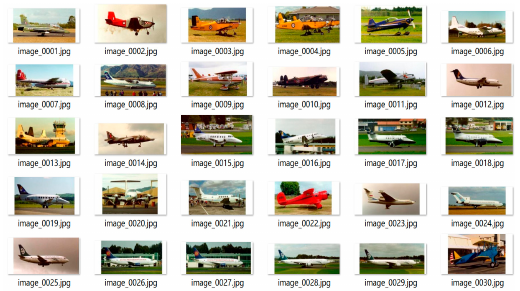
Figure 15. Balloon positive specimen training set.